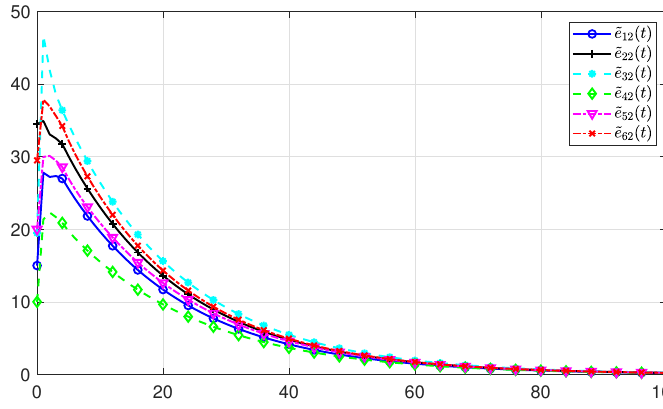
Figure 12. The simulation of ˜ e i 2 ( k ) of all the